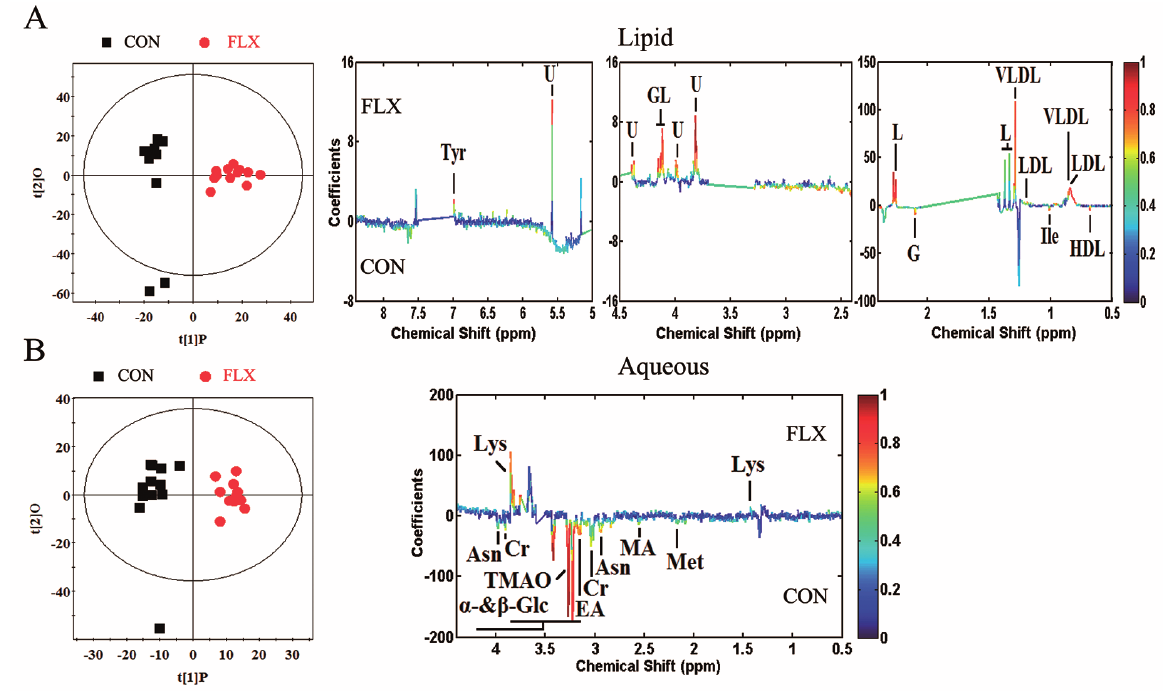
Figure 5. Orthogonal partial least-squares discriminant analysis (OPLS-DA) score plots and corresponding coefficient loading plots. OPLS-DA score plots ( left panel) and corresponding coefficient loading plots ( right panel) derived from the 1 H NMR spectra of the lipid phase ( A ) and aqueous phase ( B ) of cellular extracts obtained from CON and FLX. The color map shows the significance of metabolic variations between the two groups. Positive peaks indicate metabolites that are more abundant in the fluoxetine-treated group, while negative peaks indicate metabolites that are more abundant in the untreated control group.